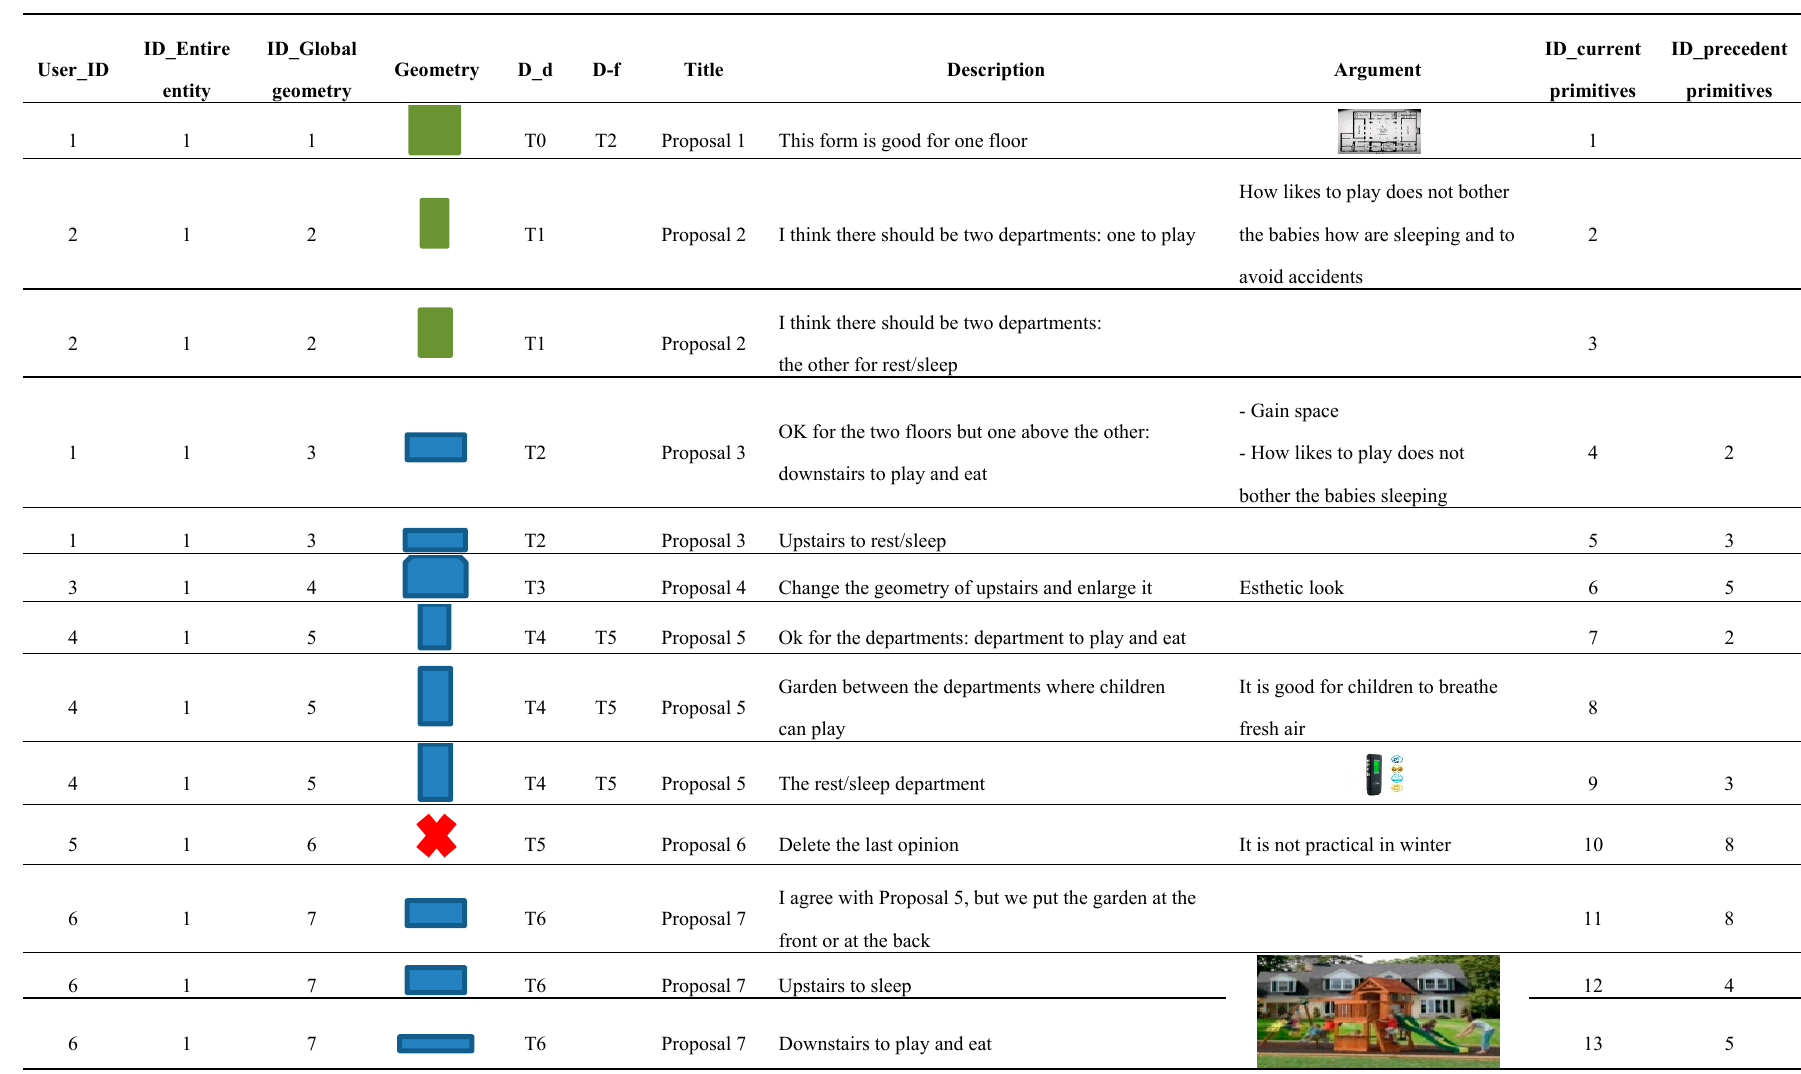
Table 3. WikiGIS